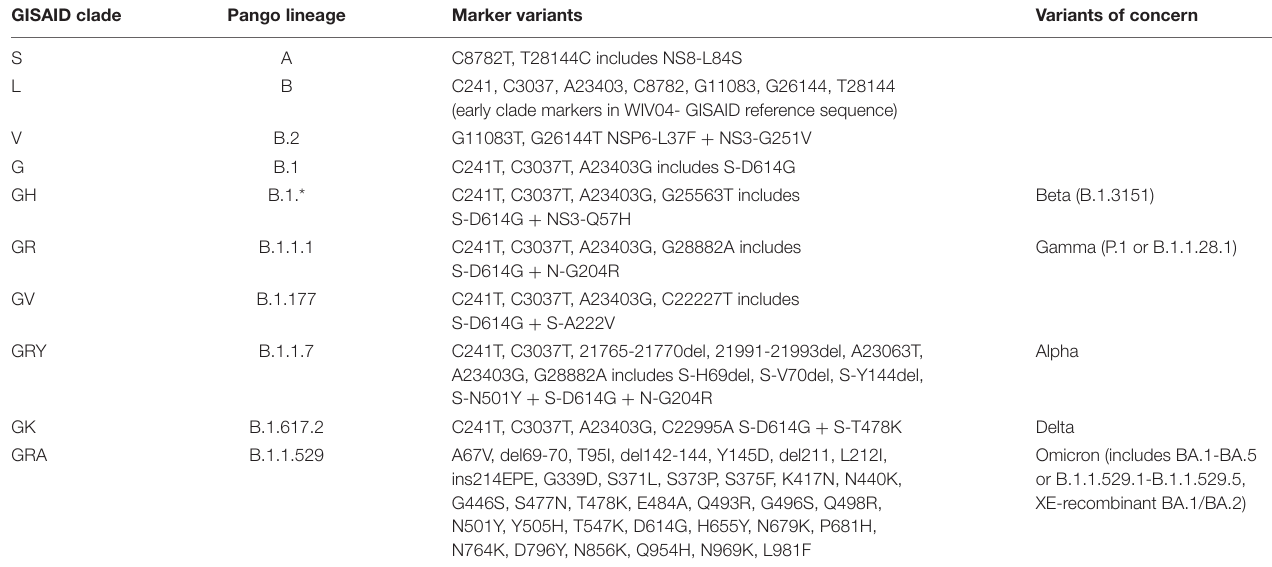
TABLE 1 | SARS-CoV-2 GISAID clade classifications, corresponding pango lineage, and variants of concern. GISAID